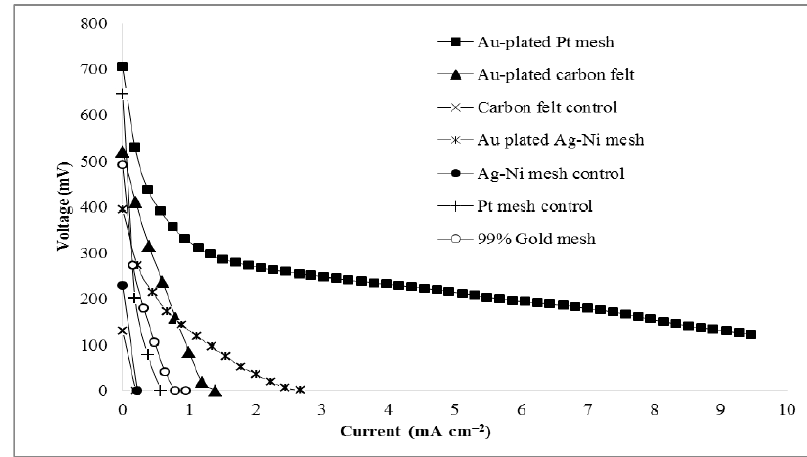
Figure 6. Polarization curves for different anodic surfaces in 8 M KOH and 1.4 M glycerol, including carbon felt with and without gold plating, Ag-plated Ni mesh with and without gold plating, platinum mesh with and without gold plating, and gold mesh.